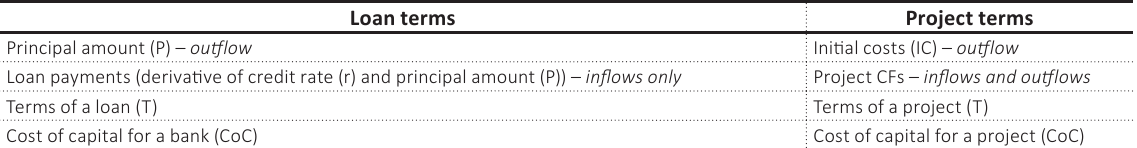
Table 1. Comparison of loan and project